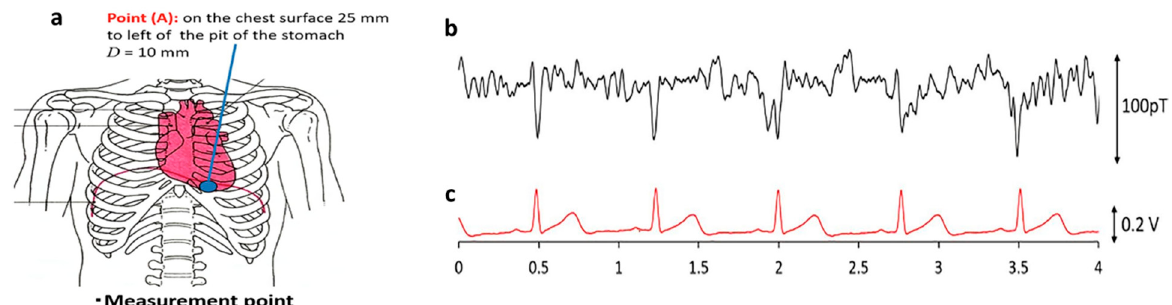
Figure 9. ( a ) Measurement location of MCG, which was 25 mm to the left of the pit of the stomach and 10 mm from the surface. ( b,c ) Real-time recordings of MCG and ECG signals measured by a peak-to-peak VD-type MI gradiometer without any magnetic shielding equipment. Reprinted with permission Ref. [86]. Copyright 2022 Elsevier.